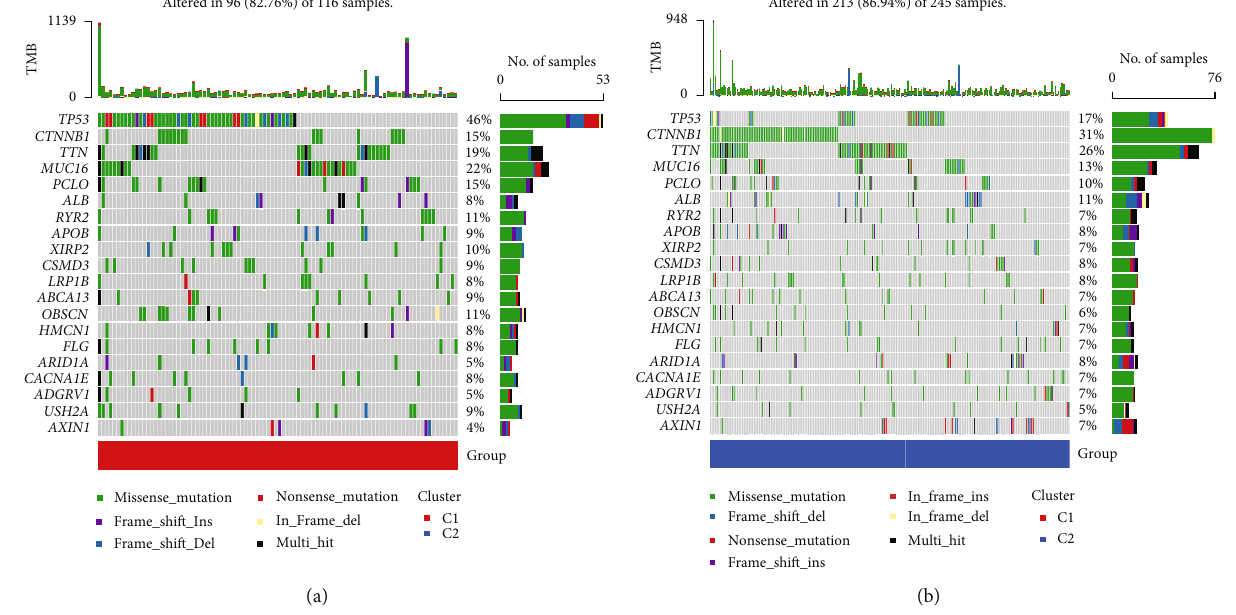
Figure 4: The somatic mutations landscape of two cuproptosis-related clusters. The top ten mutated genes in cluster 1 (a) and cluster 2 (b) were visualized using a waterfall